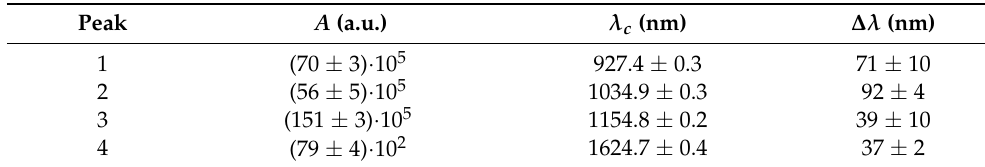
Figure 3. Fluorescence spectrum of the Rb-Ar crystal excited with 770 nm photons. The blue line represents experimental data, while purple curves are the Lorentzian fits. Table 1. Peak parameters of the fits of Figure